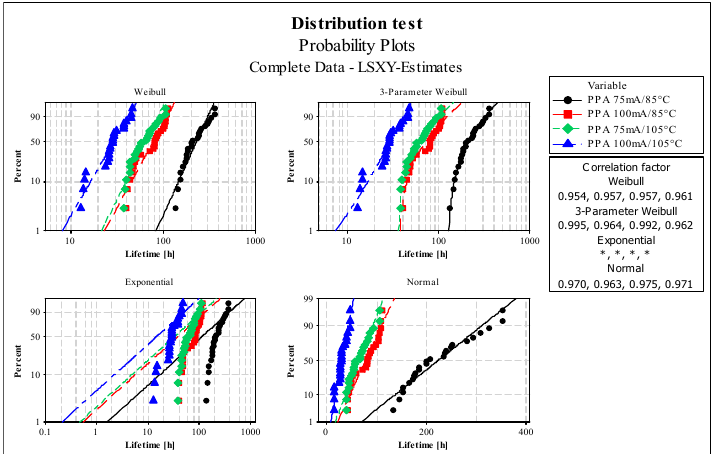
Figure 19. Distribution test with correlation factors for all tested constellations: Weibull, 3-Parameter Weibull, Exponential and Normal distributions.